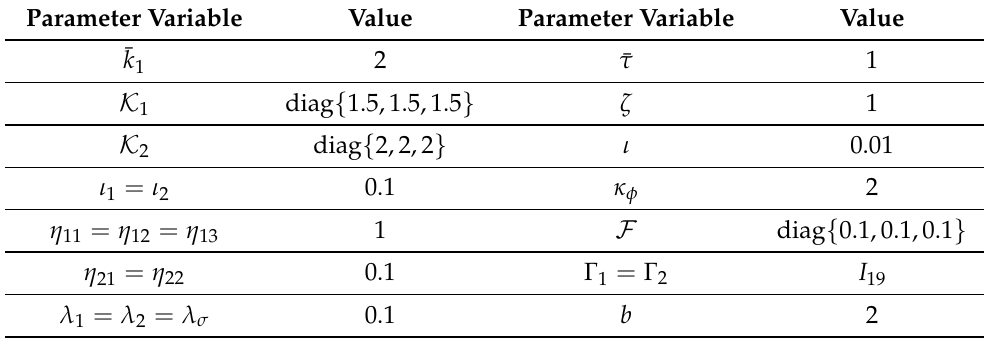
Table 3. Relevant simulation parameters of the controller and adaptive laws.